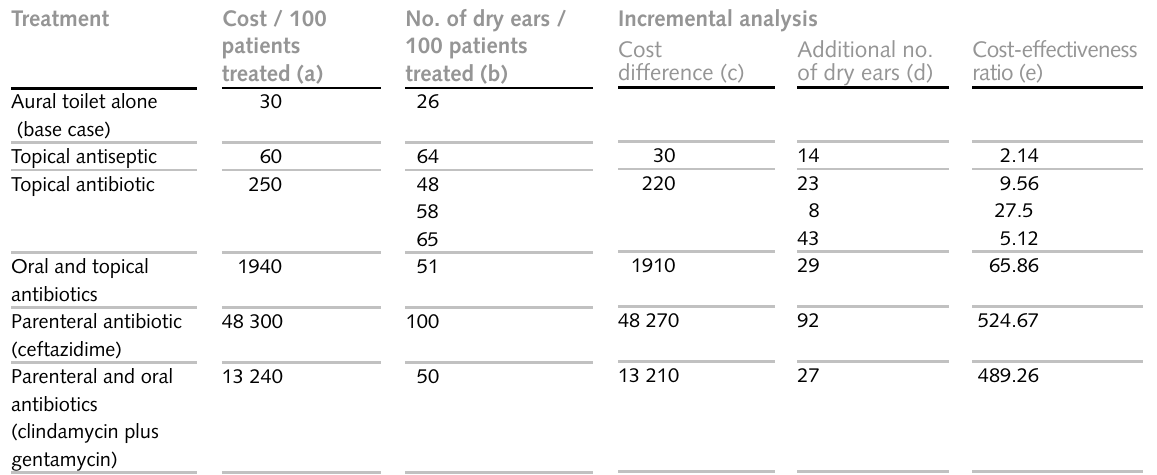
Table 11. Cost-effectiveness analysis of alternative treatments to ear wicking